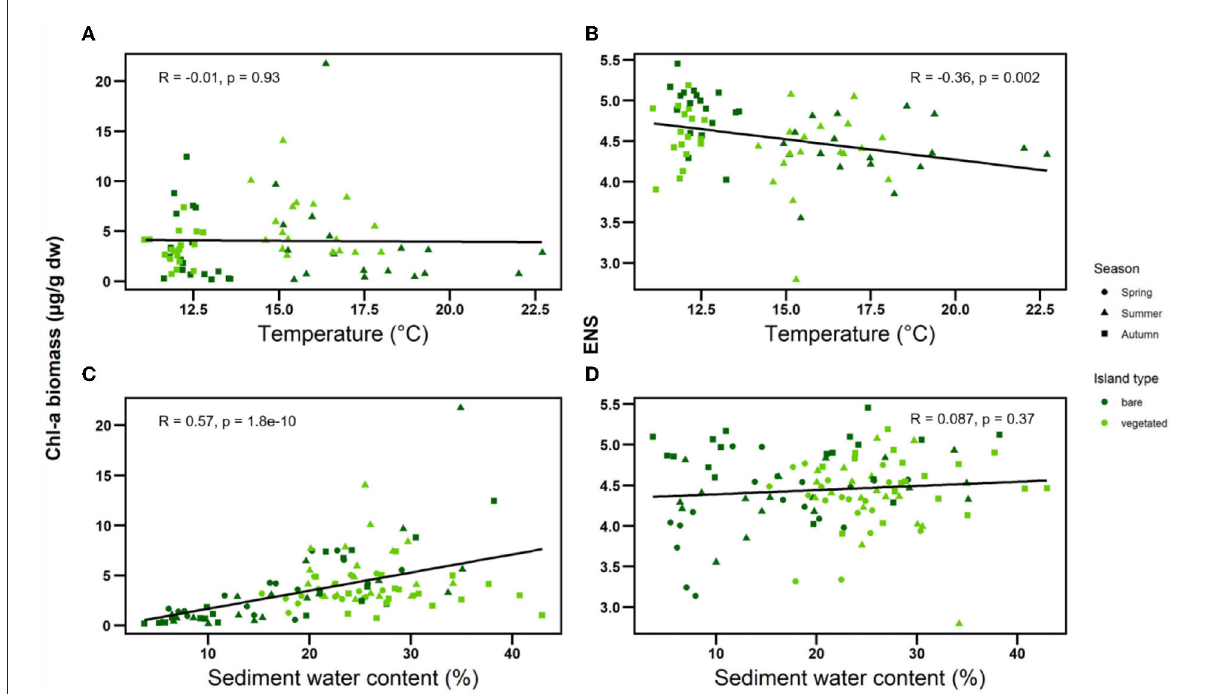
FIGURE5 Relationship between Chl-a biomass in micrograms per gram dry weight sediment ( µ g /g dw) (left panel) and pigment diversity (ENS, right panel) with physical abiotic parameters: temperature (A,B) and sediment water content (C,D) on experimental